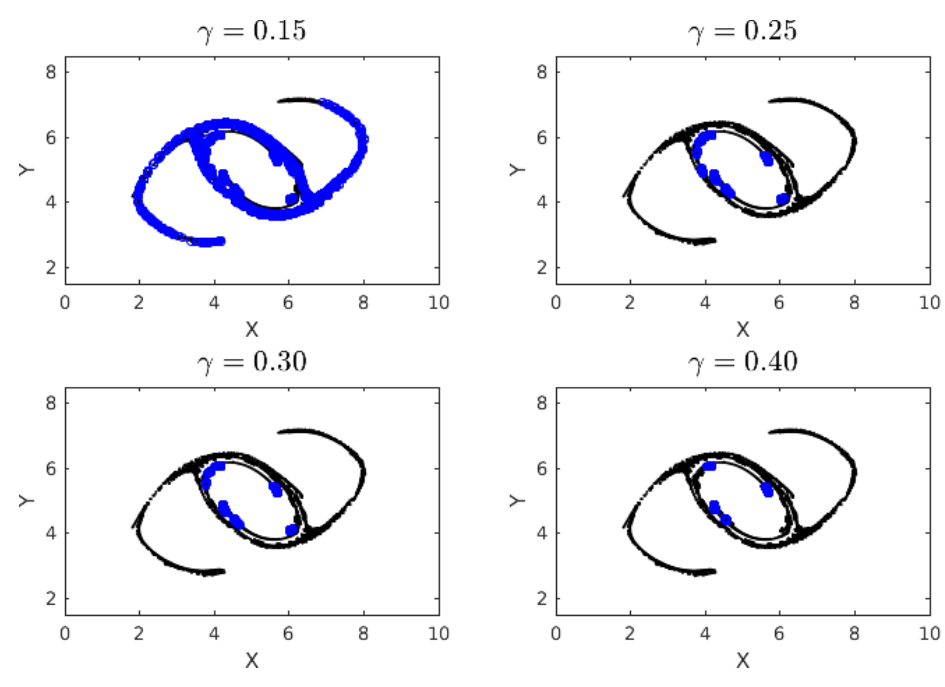
Figure 12. Dense clusters with (cid:15) = 40% for varying γ at t =